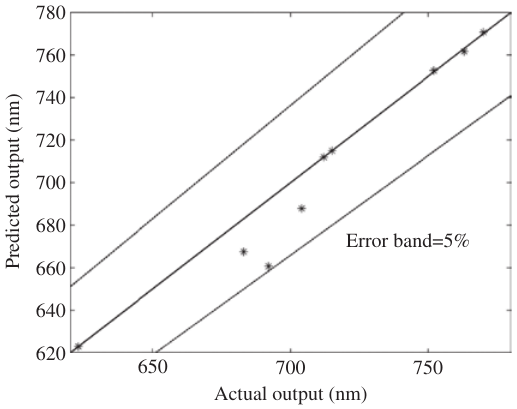
Figure 7 Diagram of predicted output in terms of actual